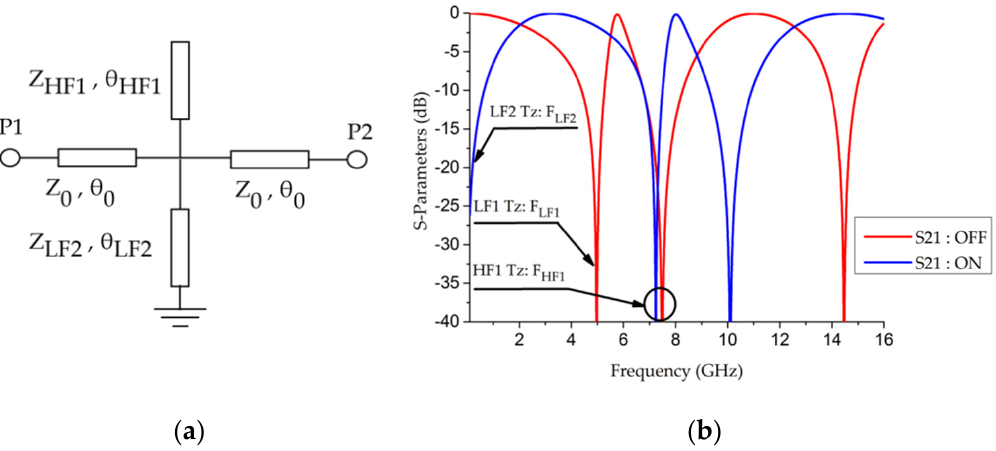
Figure 2. ( a ) DBR design in the ON state with the LF 2 stub short-circuited and the HF 1 stub open- circuited; ( b ) Example of simulated results for central frequencies of 5.7 GHz in the OFF state and 3.2 GHz in the ON state.